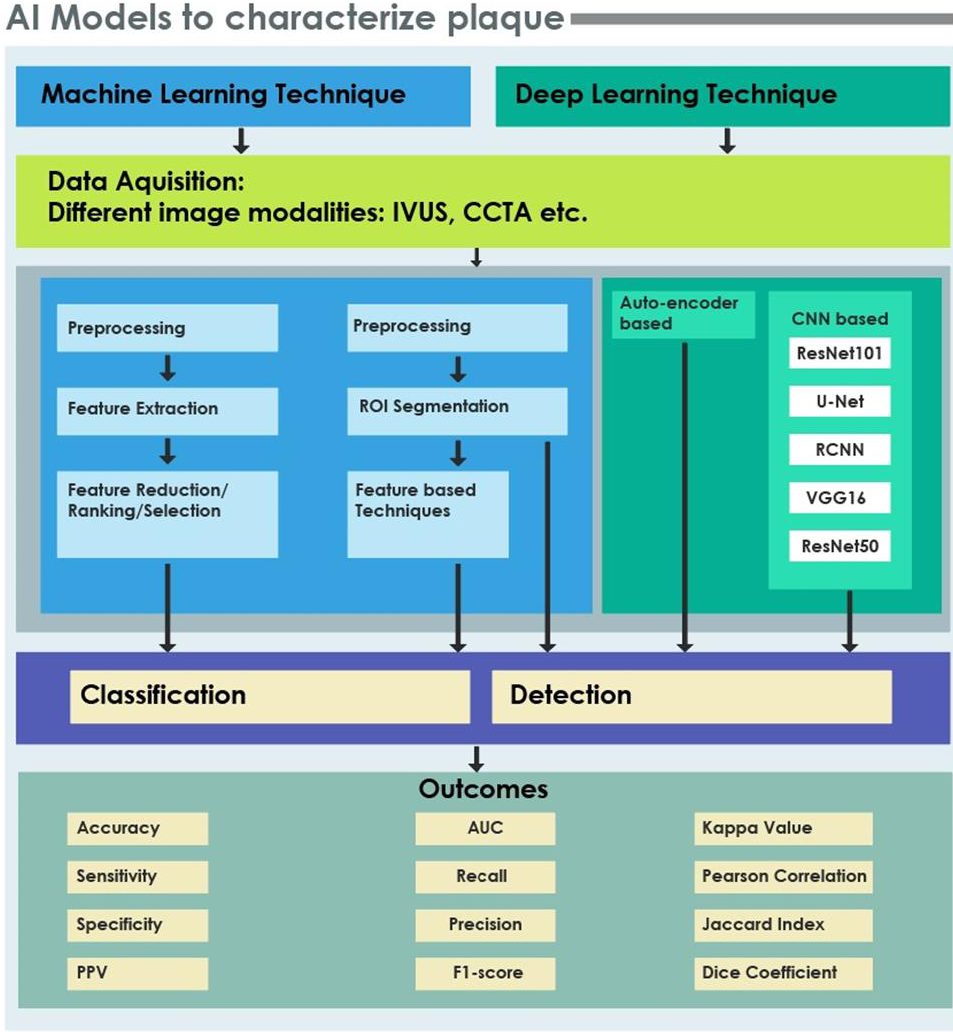
Figure 3. Processes, techniques and performance metrics of machine and deep learning models for coronary plaque characterization.